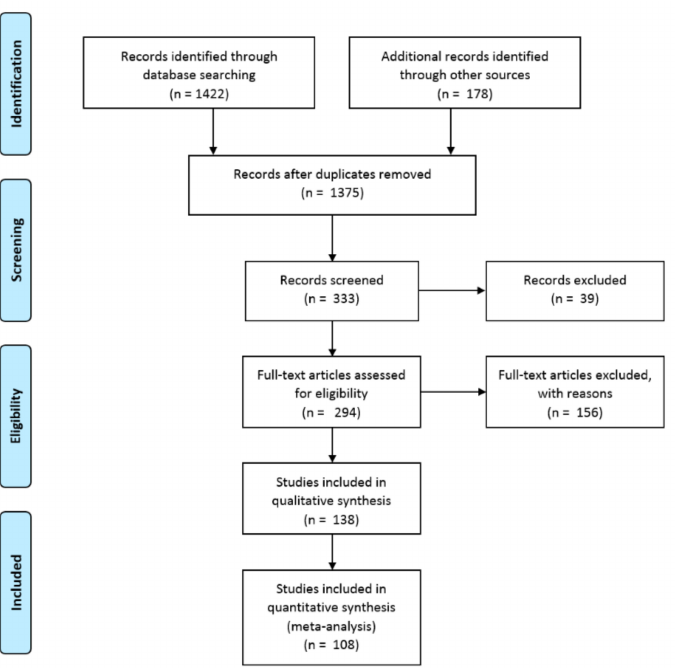
Figure 1. Preferred Reporting Items for Systematic reviews and Meta-Analyses (PRISMA) flow diagram to summarize the search and inclusion/exclusion